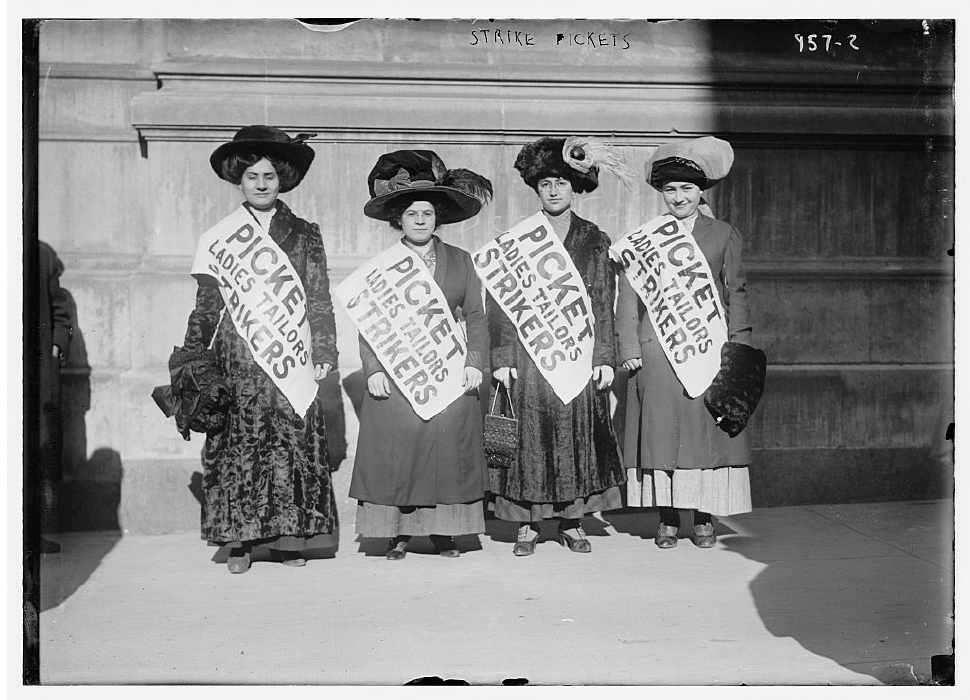
Figure 32. Bain News Service. 1910. Strike Pickets. Library of Congress.